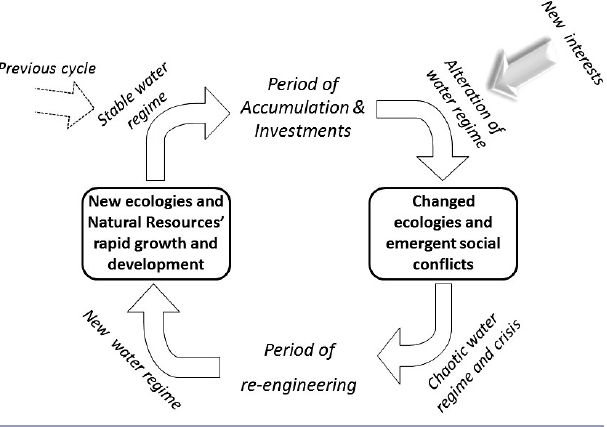
Fig. 4. A general model of cycles of capital accumulation and interventions in the western Camargue,